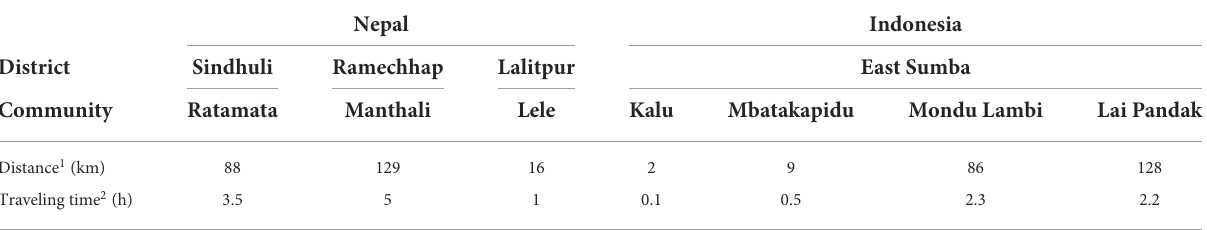
TABLE 2 Characteristics of selected farming communities. Nepal Indonesia Sindhuli